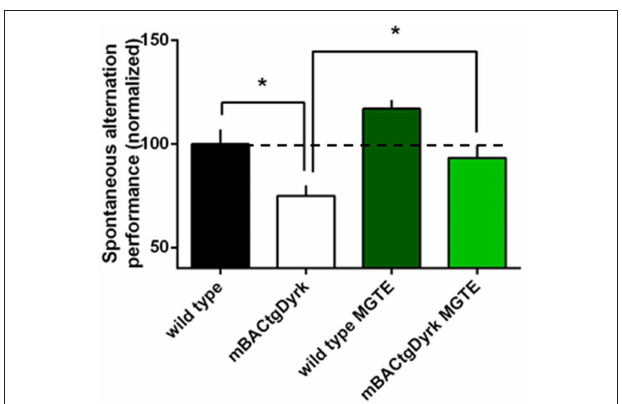
FIGURE 3 | Cognitive performance of GTE (or MGTE)-treated mBACtgDyrk1a in the Y maze. The effects of Dyrk1A overexpression on short-term spatial memory were assessed in a spontaneous alternation paradigm in a Y–maze. The data have been normalized to the baseline level of performance of wild-type mice fed with water (dotted line). One mouse from the BACtgDyrk1a group was excluded from statistical analysis because of abnormally high levels of locomotor activity and associated erratic exploration, precluding assessment of memory scores. The rate of spontaneous alternation (visiting each arm in turn) was affected by genotype: mBACtgDyrk1a mice alternated less than wild-type mice ( P < 0.05 ). Treatment with MGTE significantly improved performance of mBACtgDyrk1a mice. * p < 0.05